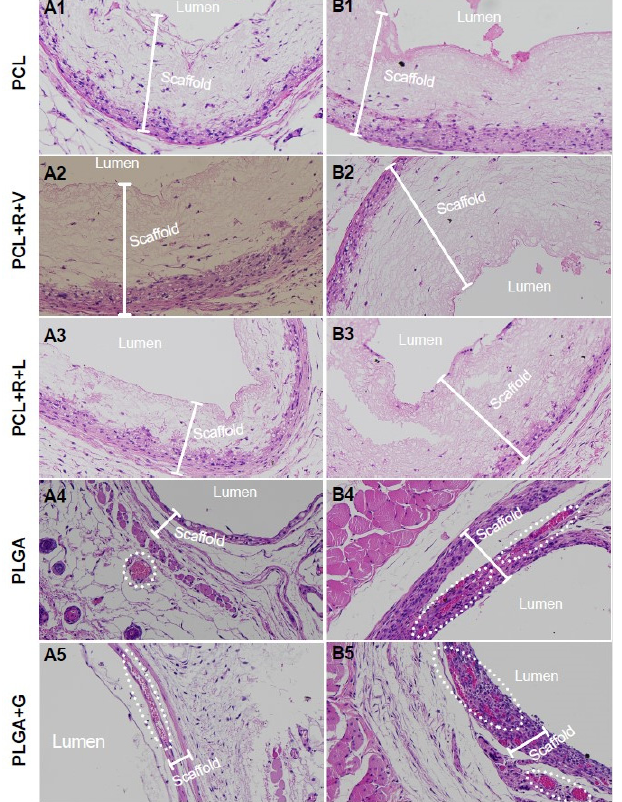
Figure 2. H&E staining of PCL ( A1 , B1 ), PCL + R + V ( A2 , B2 ), PCL + R + L ( A3 , B3 ), PLGA ( A4 , B4 ) and PLGA + G ( A5 , B5 ) scaffolds following four weeks post-implantation in the subcutaneous space of naïve B6.129S7-Rag1 tm1Mom/J ( A ) and C57BL/6 mice ( B ). PCL, PCL + R + V and PCL + R + L scaffolds were cellularized predominately at the outer surface of the scaffold, whereas the PLGA and PLGA + G scaffolds were more thoroughly cellularized and integrated with host tissues. Double-headed arrows indicate the scaffold, and dotted circles indicate